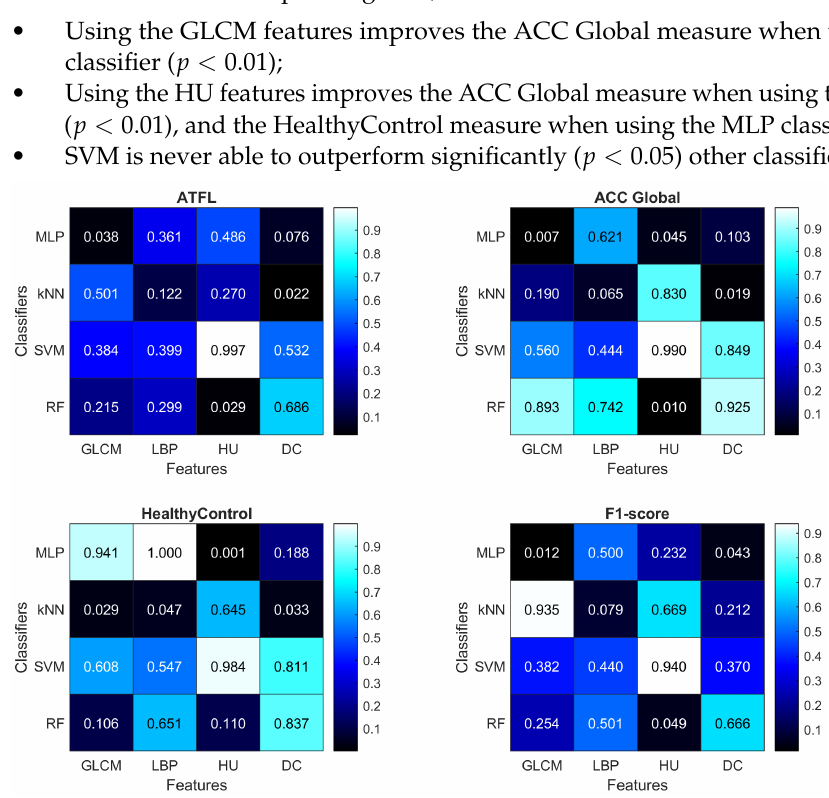
Figure 6. Results of the statistical t -test ( p -values) for various combinations of feature sets and